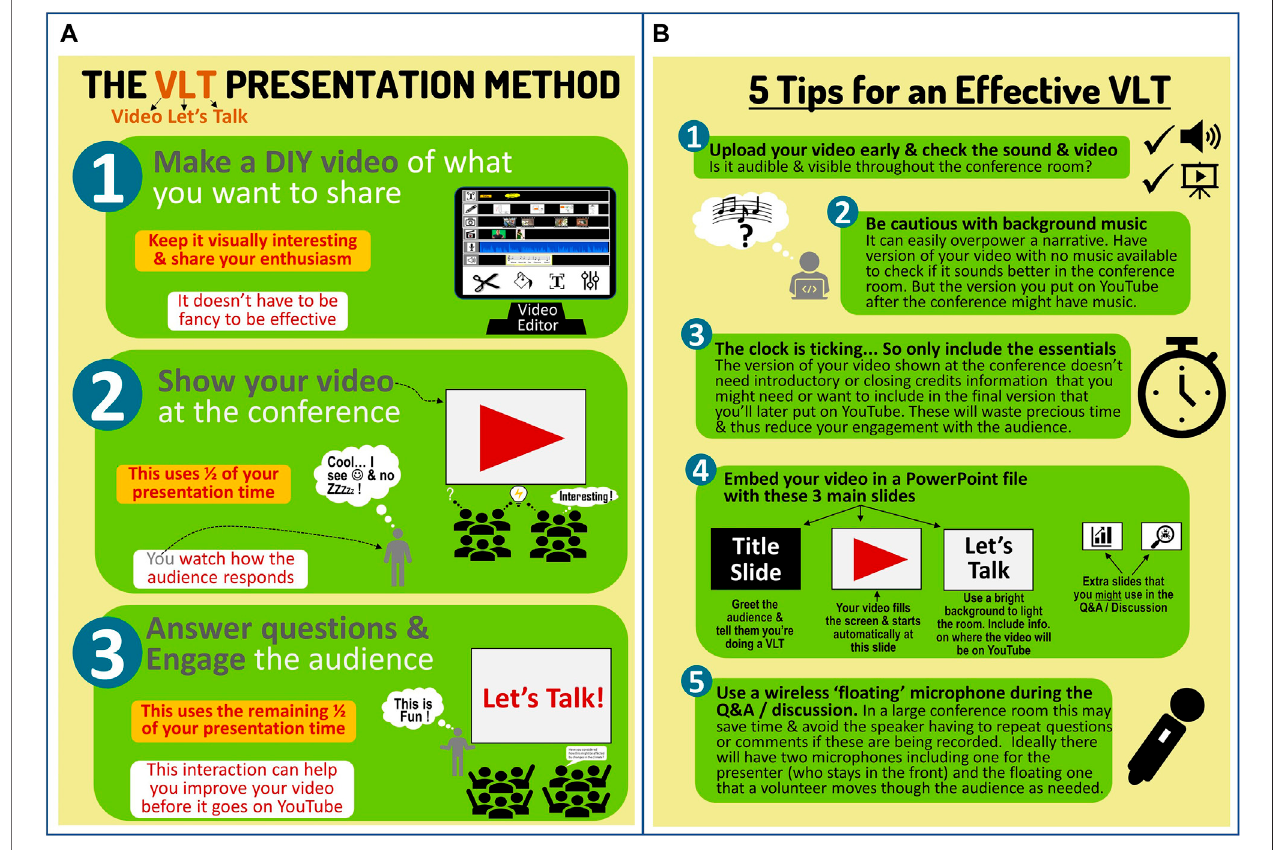
FIGURE 1 | Overview for the Video Let ’ s Talk method (A) and tips on how to do it well (B) .